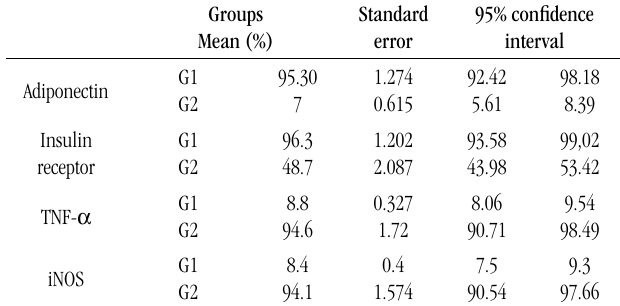
tABLE 3 – Descriptive measures of percentage values of positivity and of the respective tests F (Anova), found for adiponectin, insulin receptor, TNF- α and